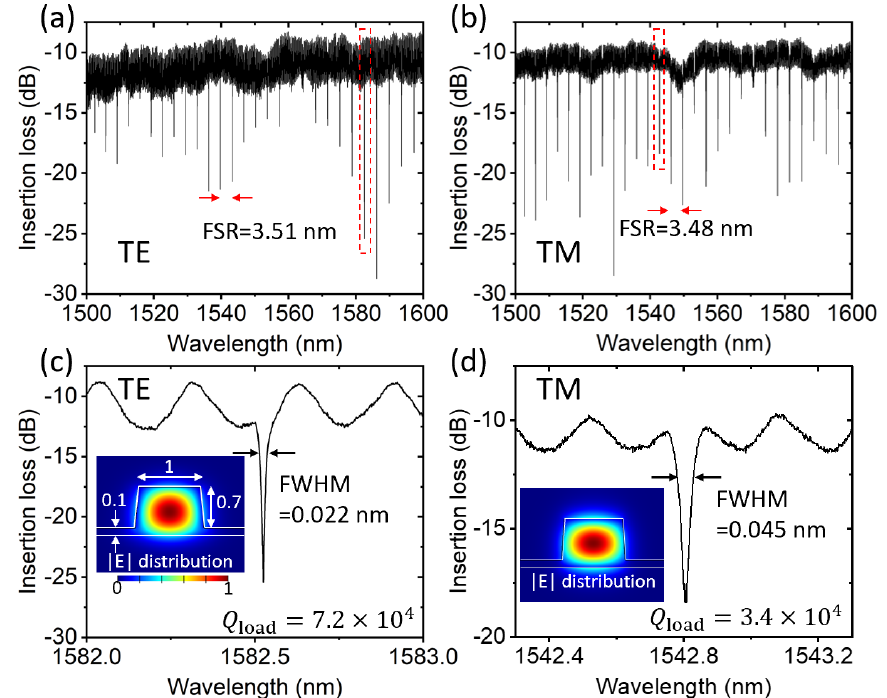
Figure 5. Measured transmission spectra normalized to the lens-to-lens coupling in ( a ) TE and ( b ) TM polarizations of a microring resonator. ( c , d ) Zoom-in views of the resonances within the red dashed-line boxes of ( a ) and ( b ), respectively. Insets: Numerically simulated TE- and TM-polarized mode-field amplitude distributions with the waveguide dimensions labeled in μ m units.